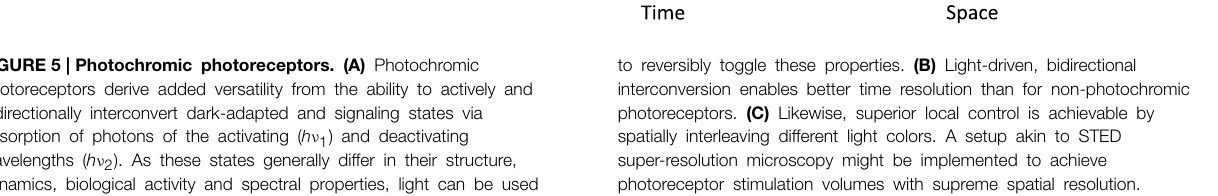
FIGURE 5 | Photochromic photoreceptors. (A) Photochromic photoreceptors derive added versatility from the ability to actively and bidirectionally interconvert dark-adapted and signaling states via absorption of photons of the activating ( h ν 1 ) and deactivating wavelengths ( h ν 2 ). As these states generally differ in their structure, dynamics, biological activity and spectral properties, light can be used